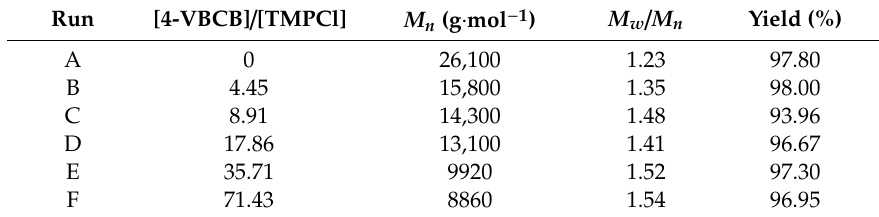
Table 2. Poly(IB- co -4VBCB) with di ff erent feed quantities of 4-VBCB initiated by the TMPCl / TiCl 4 /